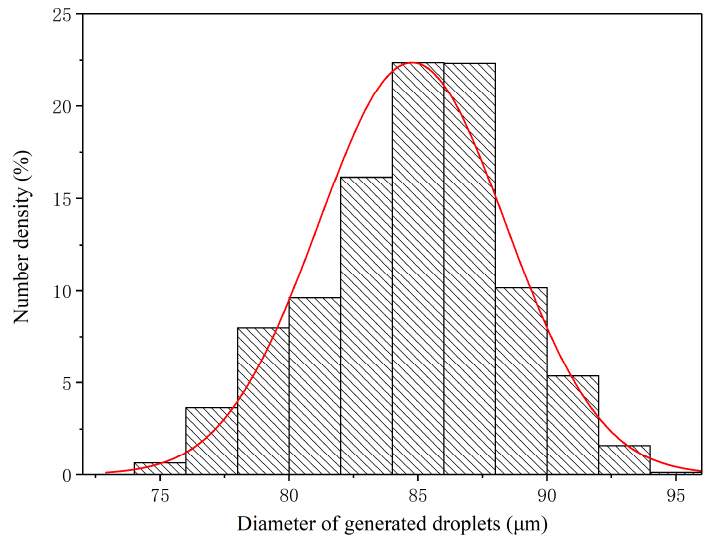
Figure 11. Size distribution of generated monodisperse droplets under OC3 ( q = 40 mL/h, f = 40 kHz).